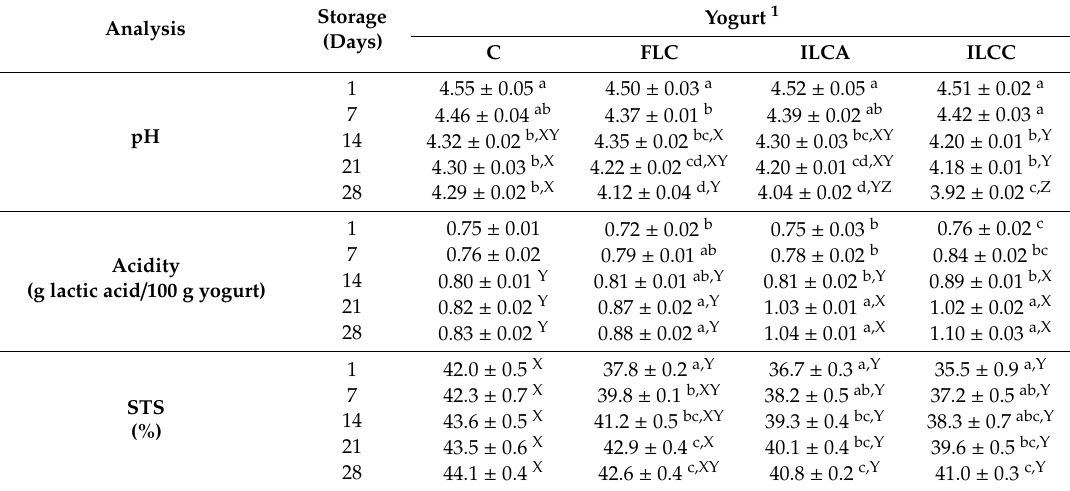
Figure 1. Acidification kinetics during yogurt production. (C = Yogurt produced with CH-1 culture; FLC = yogurt produced with freeze-dried free L. casei ATCC 393 cells and CH-1 culture; ILCA = yogurt produced with freeze-dried immobilized L. casei ATCC 393 cells on apple pieces and CH-1 culture; ILCC = yogurt produced with freeze-dried immobilized L. casei ATCC 393 cells on casein and CH-1 culture). Table 1. Physicochemical characteristics of yogurts during storage at 4 ◦ C for up to 28